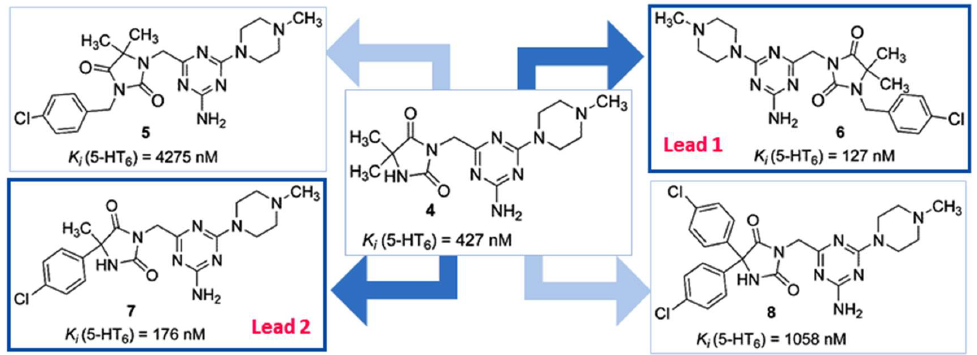
Figure 2. The rationale for the design of novel lead structures of the 5-HT 6 R ligand among hydantoin 1,3,5-triazine derivatives.